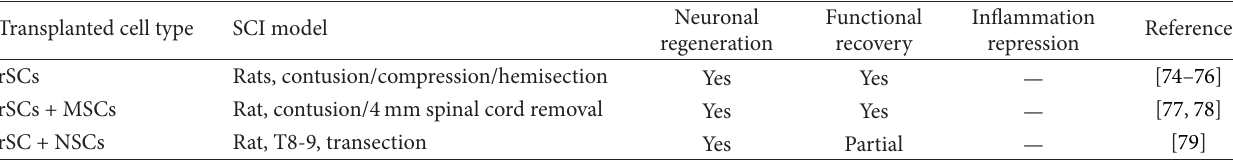
Table 5: Preclinical spinal cord injury trials using Schwann cells (SCs).